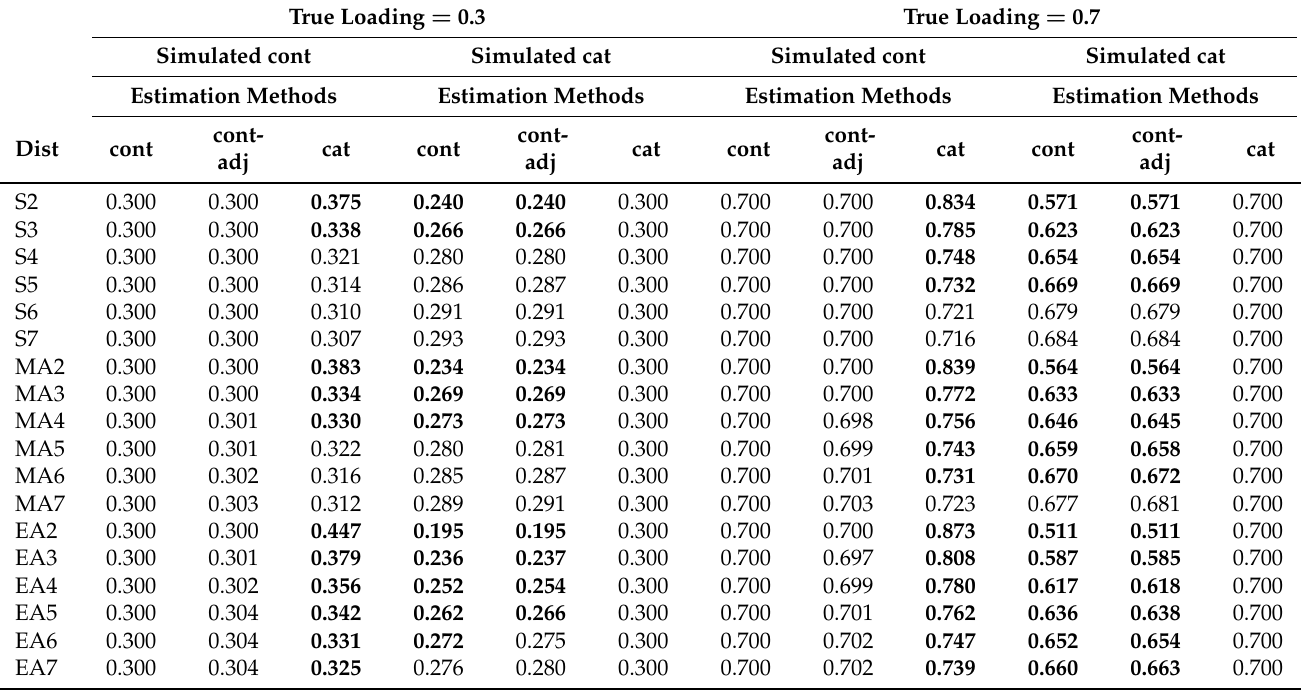
Table 1. Simulation Study 1: Estimated factor loadings for a factor correlation of 0.5 as a function of data-generating models, estimation methods, and true factor